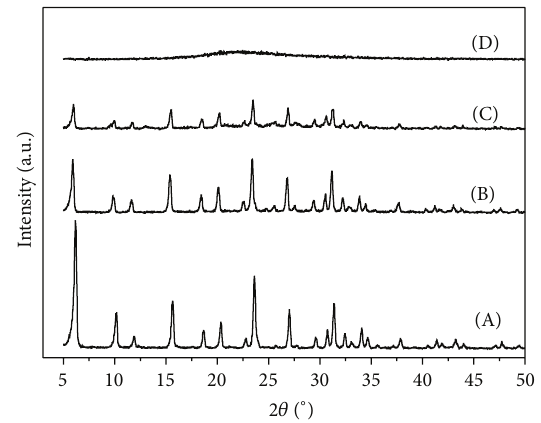
Figure 1: XRD patterns for NaY zeolite samples with different H 2 SO 4 /Al 2 O 3 and different crystallization time. (A) NaY-0-12, (B) NaY-0.67-48, (C) NaY-1.34-312, and (D)